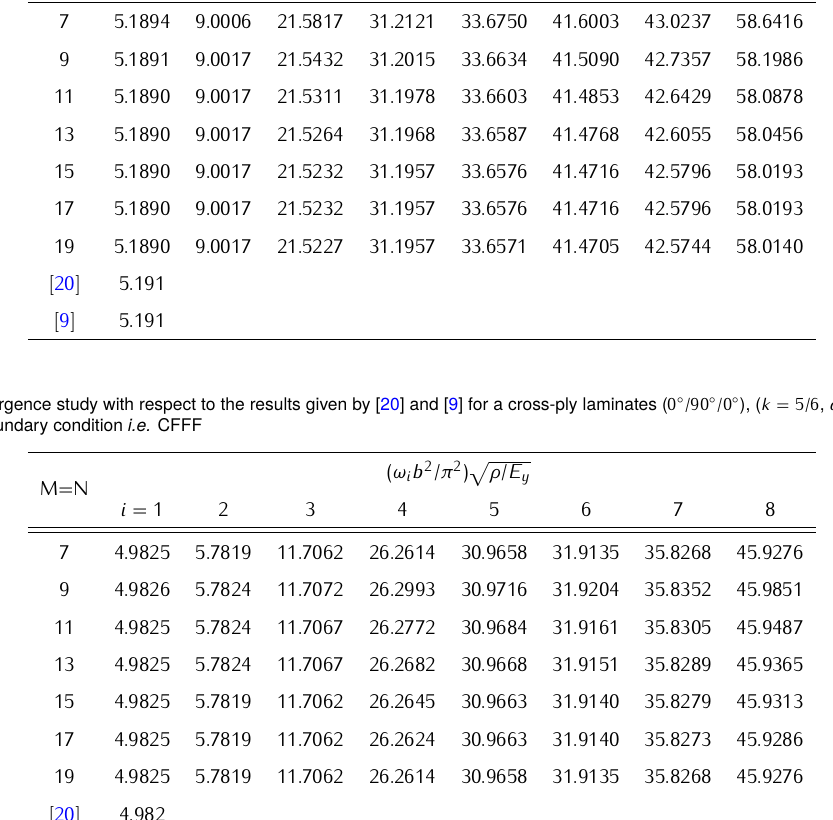
0 ◦ / 90 ◦ / 0 ◦ ), ( k = 5 / 6 , a/b = 1 , h/b = 0 . 01 )